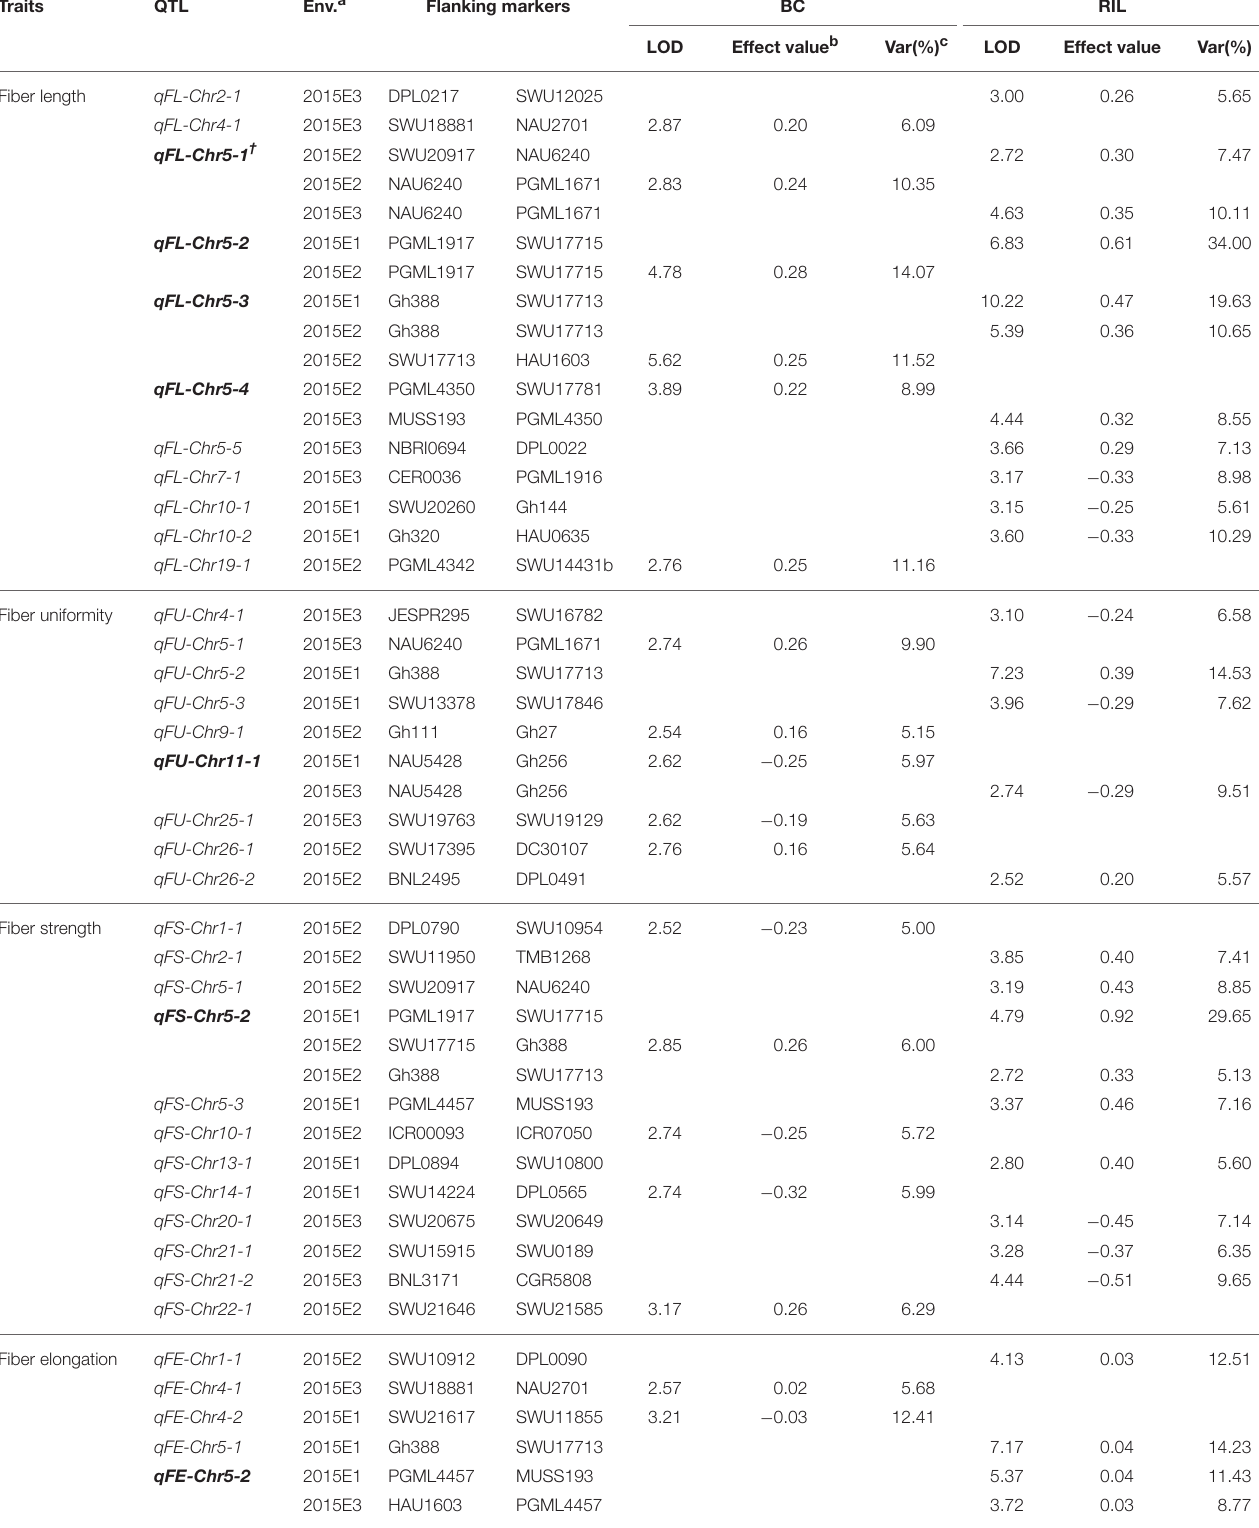
TABLE 4 | QTLs detected by single-locus analysis in RIL and BC populations. Traits QTL Env. a Flanking markers BC RIL LOD Effect value b Var(%) c LOD Effect value